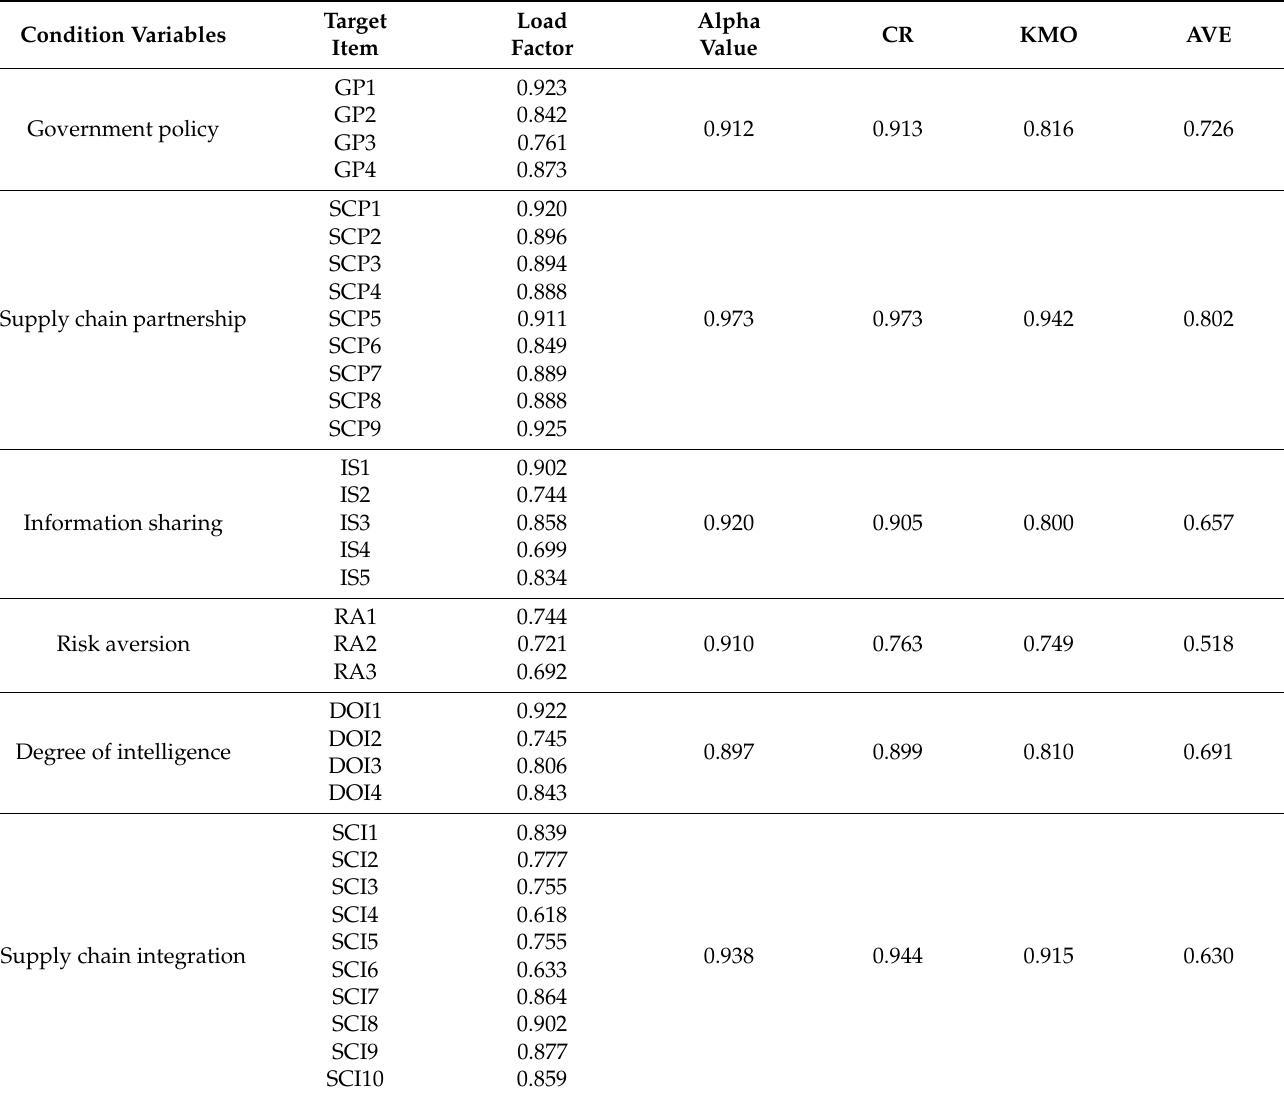
Table 3. Reliability and validity analysis of